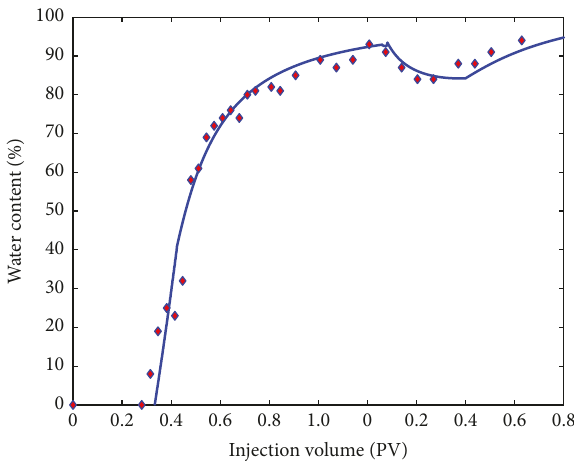
Figure 4: Comparison of experimental data and the presented model.